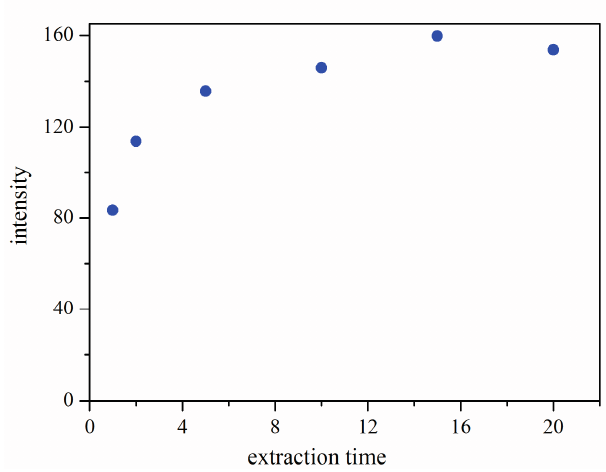
Figure 5. Effect of extraction time on extraction